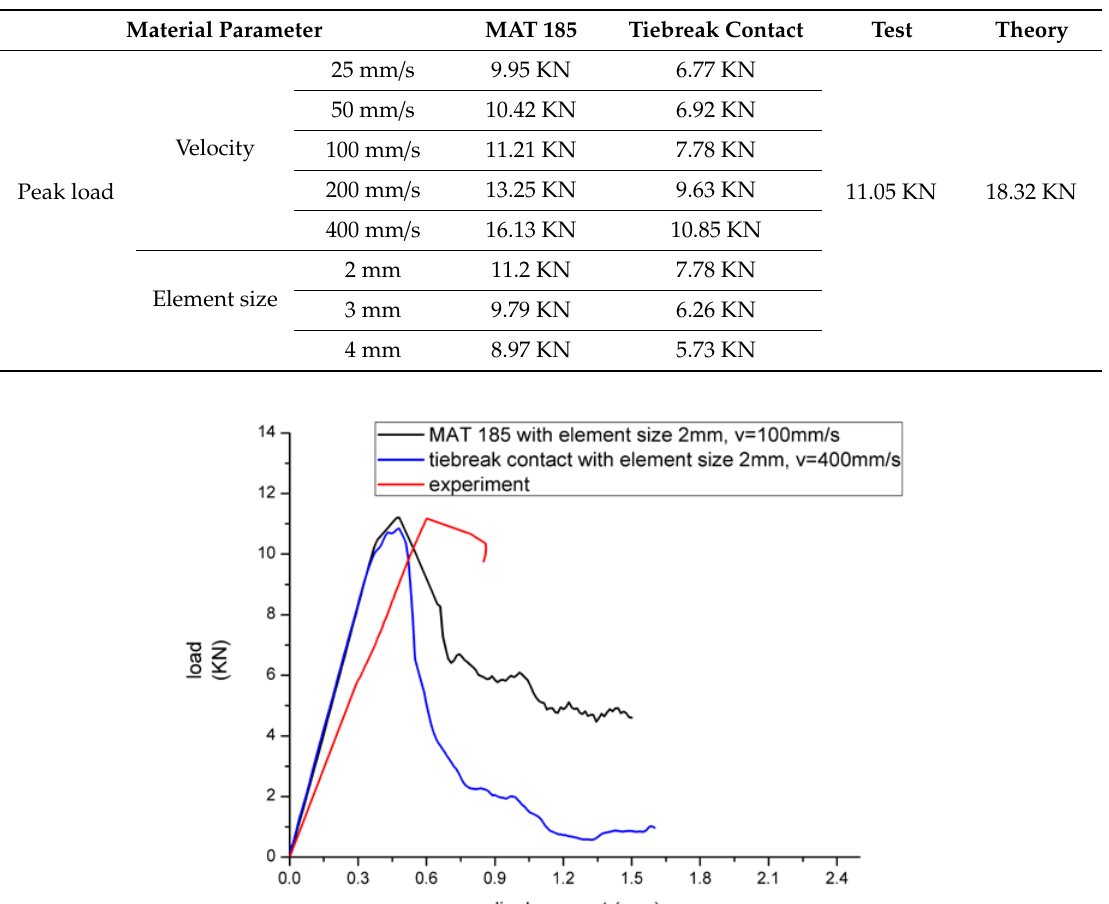
Table 2. Comparison of simulation, experiment, and theoretical results with peak load.